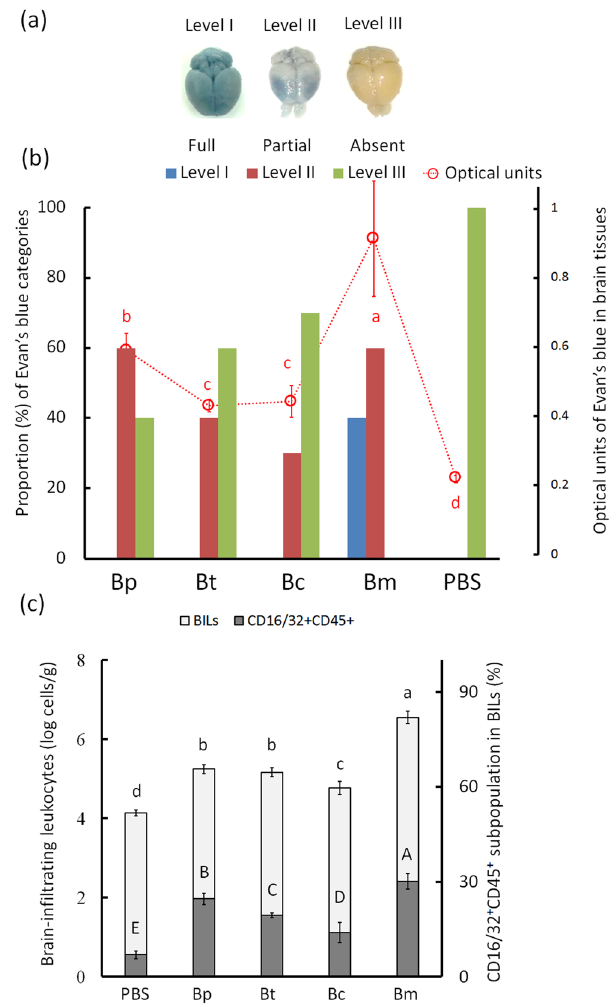
Figure 5. Vascular permeability and brain-infiltrating leukocytes. The endotoxemic mice were intravenously injected with Evan’s blue dye (2% in saline, 4 mL/kg). After one hour, the distribution of Evan’s blue was used to categorize the brains into three groups: level I (full distribution), level II (partial distribution and level III (absent) ( a ). The proportions (%) of brains that were level I versus level III in each Burkholderia LPS-induced group as well as the optical units of Evan’s blue in the homogenized brains are shown ( b ). Brain-infiltrating leukocytes (BILs) were collected from endotoxemic mice. The total number of BILs and the proportion of CD16/32 + CD45 + cells are shown ( c ). The letters a-d or A-E represent significant differences at p < 0.05 (one- way ANOVA; Tukey’s HSD